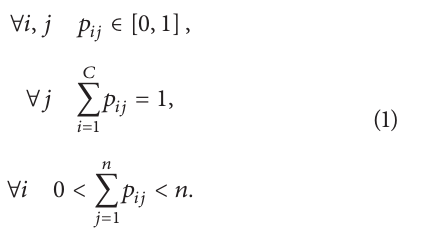
the membership of the data point 𝑥 𝑖 for the 𝑖 th cluster. The